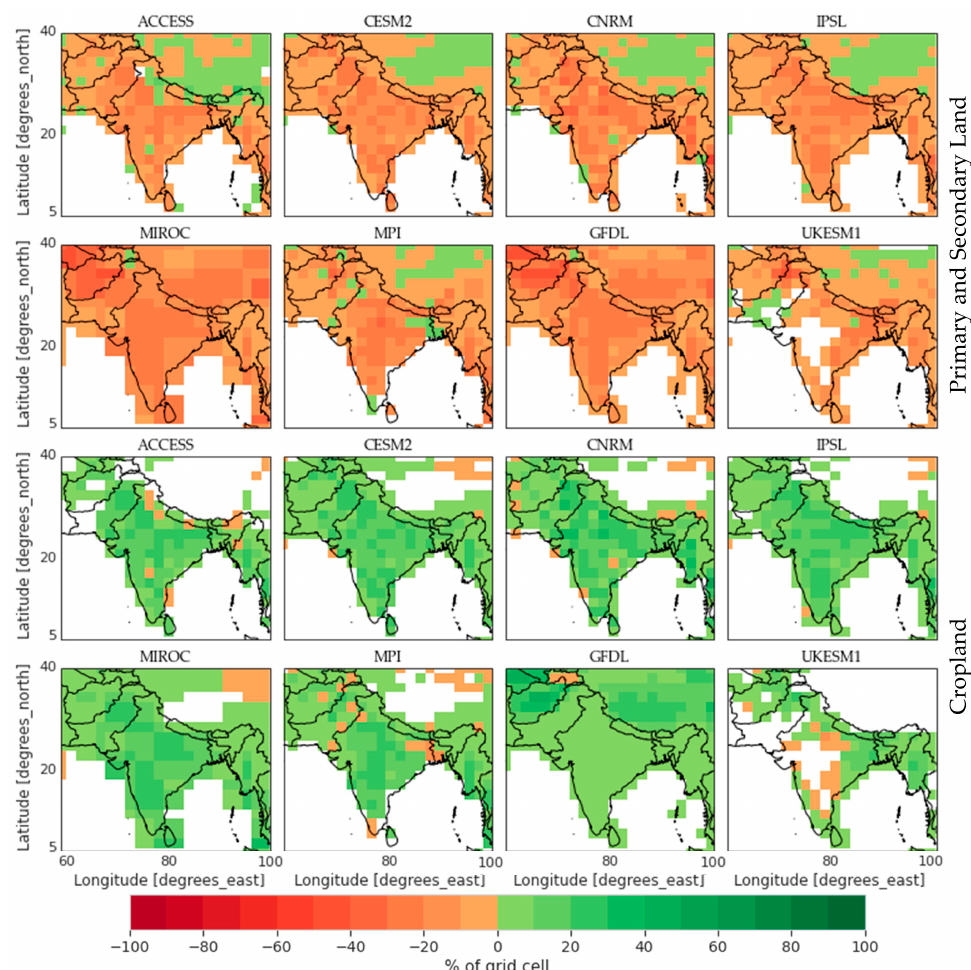
Figure 3. Spatial distribution of the LULCC retrieved from fracLut variable. Negative values indicate a loss and positive ones are a gain in the respective grid cells. Maps display the mean annual values between 1950 to 2014.